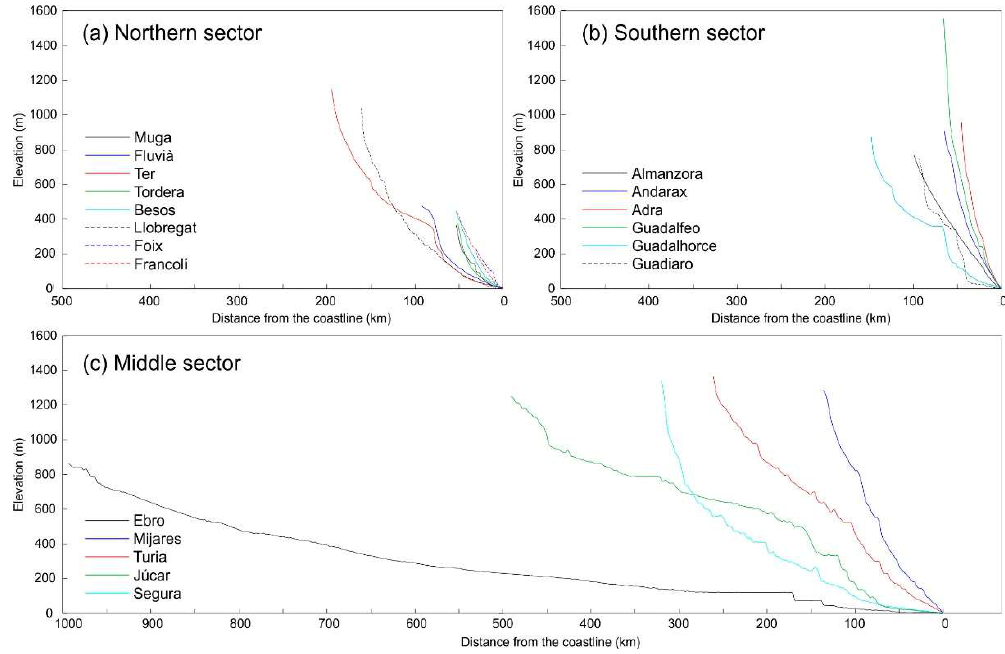
Table 3. Geomorphologic and geologic characteristics of the studied rivers.